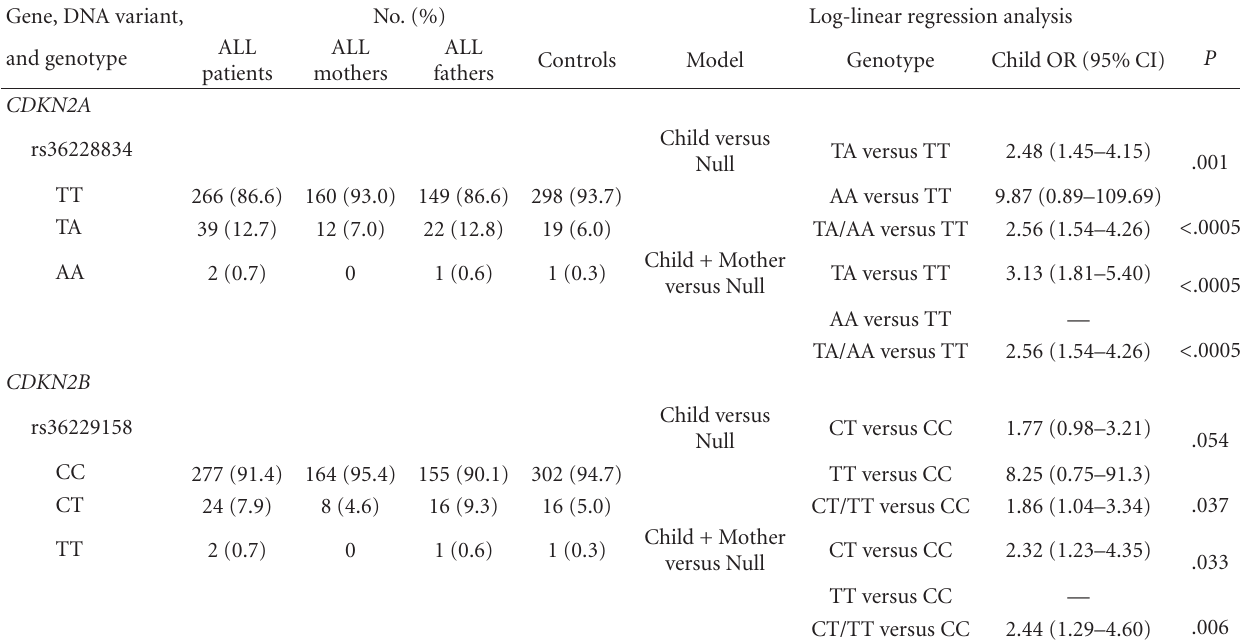
Table 5: Distribution of CDKN2A rs36228834 and CDKN2B rs36229158 genotypes and associated risk estimates for pre-B ALL susceptibility among children. Gene, DNA variant,